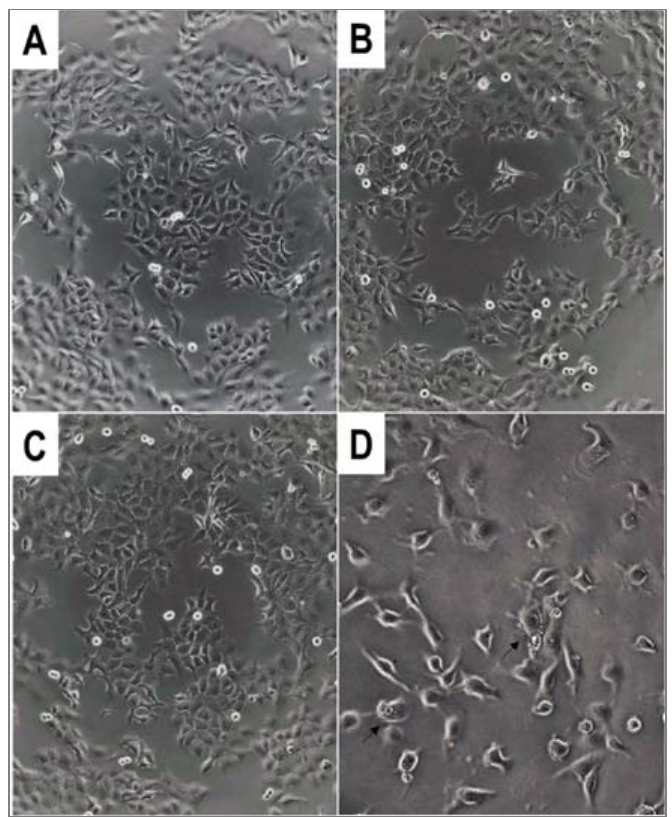
Figure 2. Morphology of A431 human skin carcinoma cells after overnight treatment with α - hydroxyphoshpnate derivatives 4c* and 4d at c = 50 µ M. ( A ) Untreated control (100 × magnification); ( B ) 4c* (100 × ); ( C ) 4d (100 × ); ( D ) 4d (200 × ). Arrows show membrane blebbing. Table 5. Cytostatic effect $ of α‐ hydroxy ‐ benzylphosphonate derivatives against human tumor cell lines.